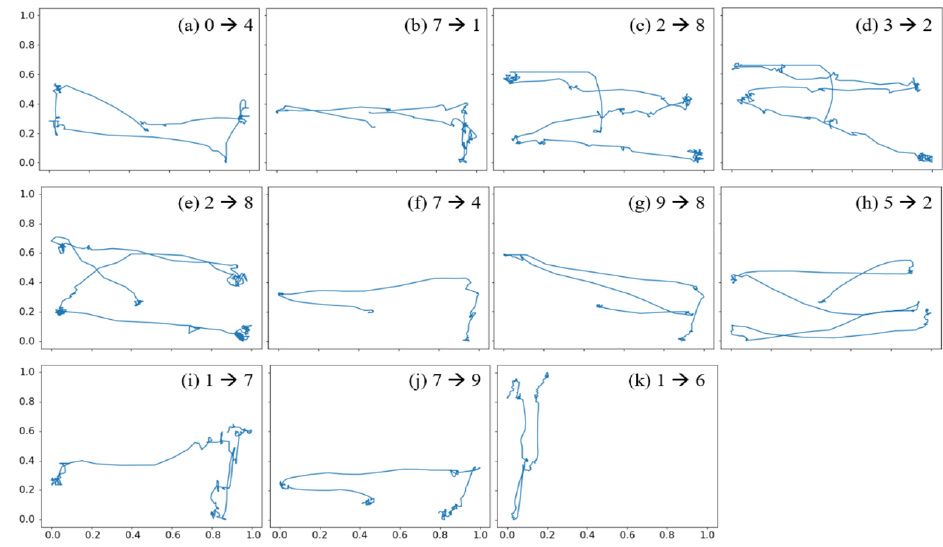
Figure 7. Misrecognized eye-written characters from ( a ) to ( k ). A → B in each subfigure denotes the number A misclassified as B.